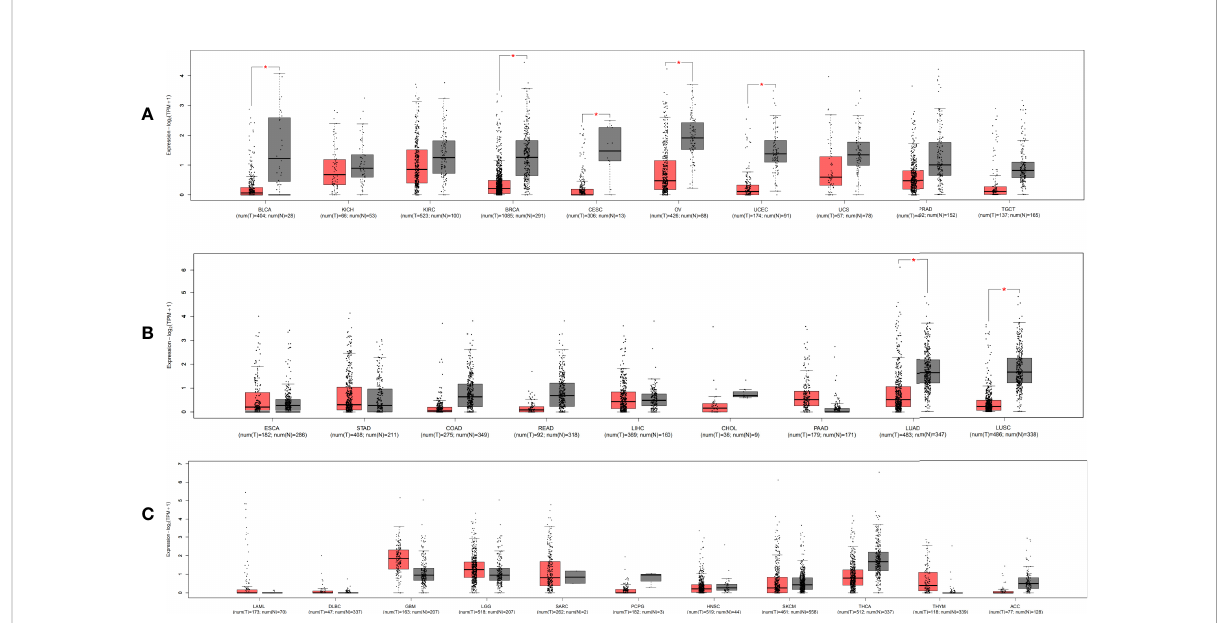
FIGURE 3 The relative expression level of MIR100HG in pan-cancer and adjacent normal tissues. The expression level of MIR100HG in different tissue of the digestive and respiratory systems. (A) urogenital system; (B) and other systems; (C) * |Log2FC|>1, p < 0.01. Data extracted from GEPIA2, all abbreviations in this fi gure refers to TCGA database (Supplementary Table